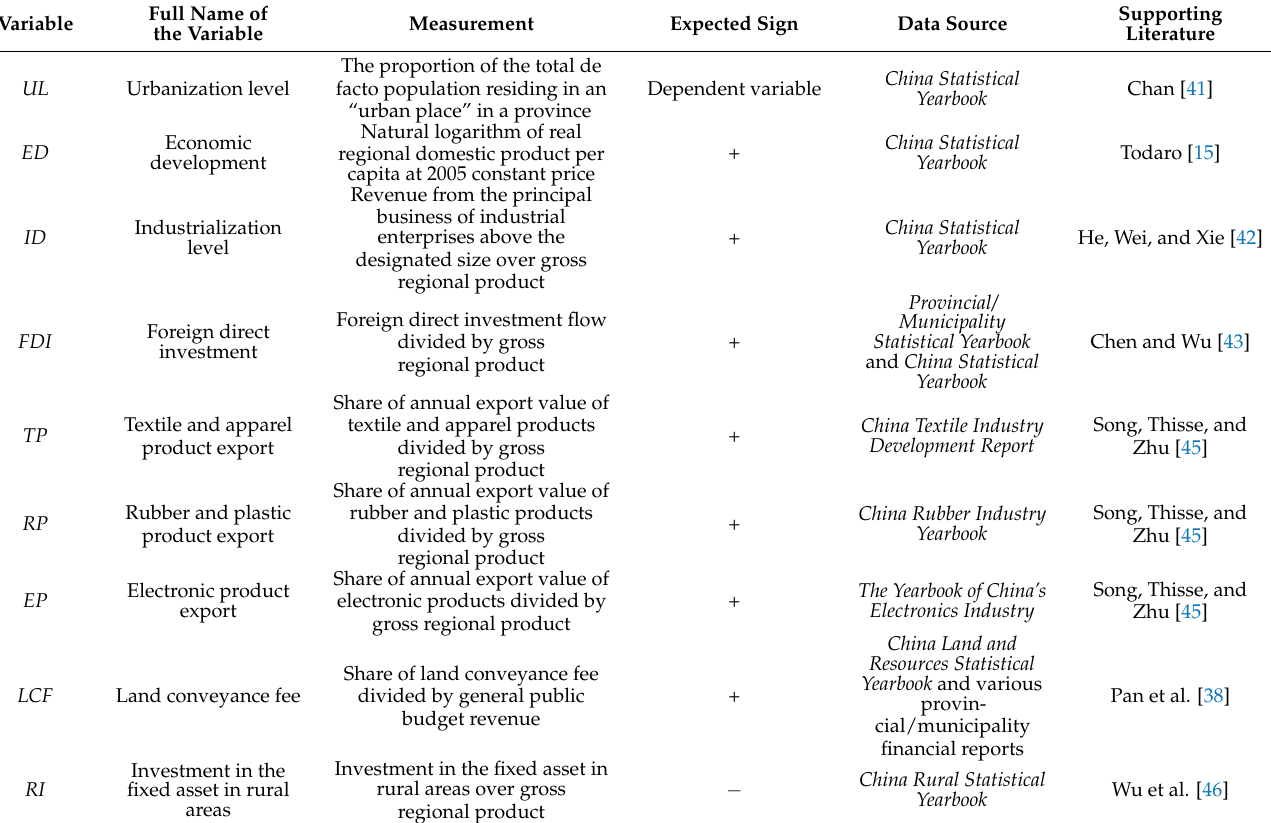
Table 1. Measurement, data sources, and supporting references for the variables employed in this